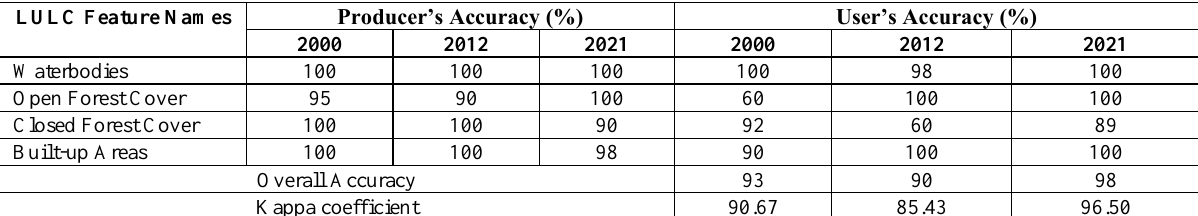
Table 1. Summary of Overall Accuracy and Kappa Coefficient LULC Feature